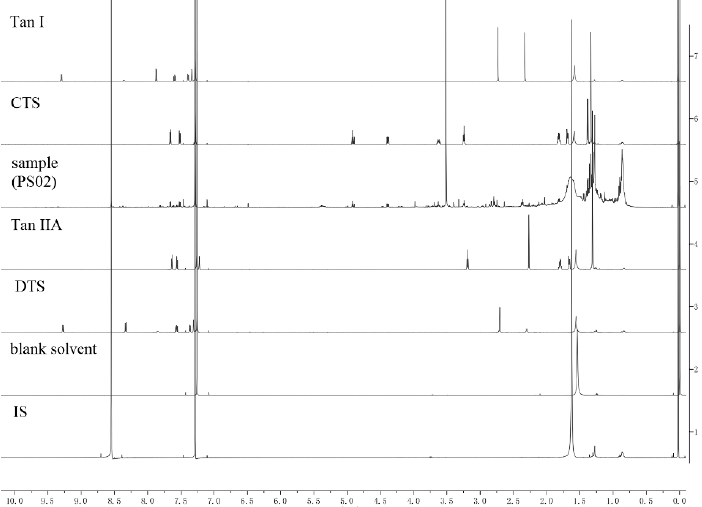
Figure 2. 1 H-NMR spectra of Tan Ⅰ , CTS, sample (PS02), Tan Ⅱ A, DTS, blank solvent and IS.